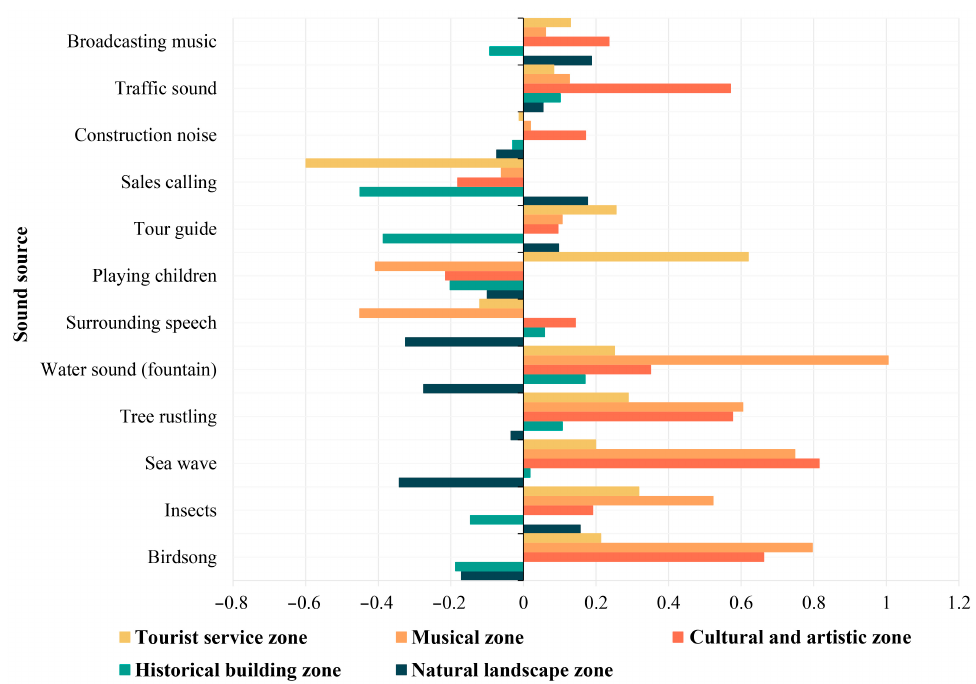
Figure 3. Mean values of harmonious degree of sound sources in different functional zones.